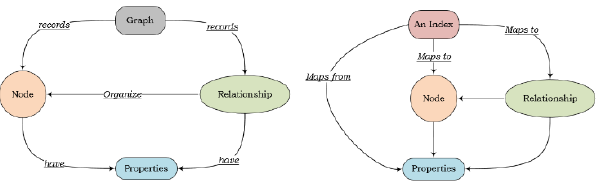
Figure 4. Graph node and